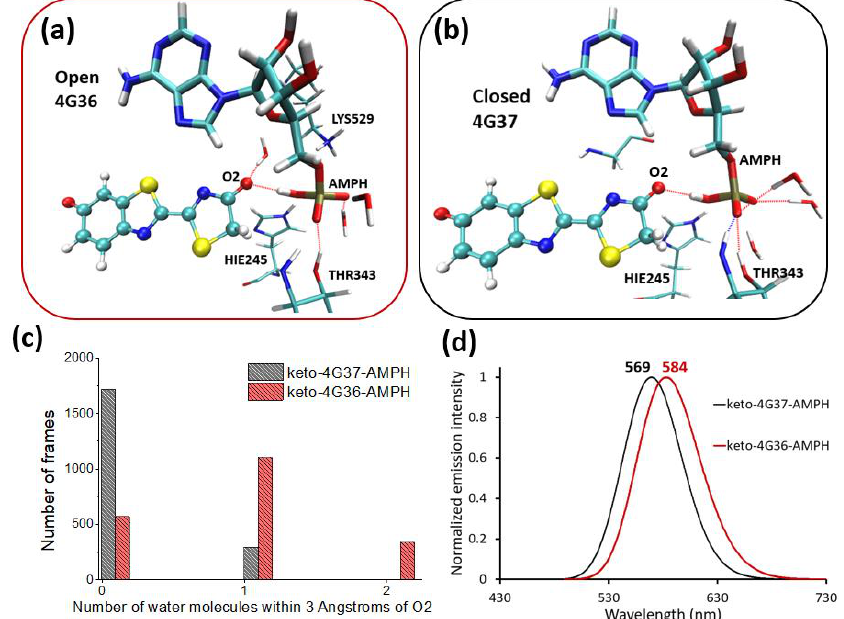
Figure 3. Graphical representation of the hydrogen-bond patterns found along the simulations of ( a ) keto-4G36-AMPH and ( b ) keto-4G37-AMPH. ( c ) Histogram showing the number of water molecules within 3 Angstroms of O2 during the simulation. ( d ) Simulated emission spectra for keto-4G36-AMPH and